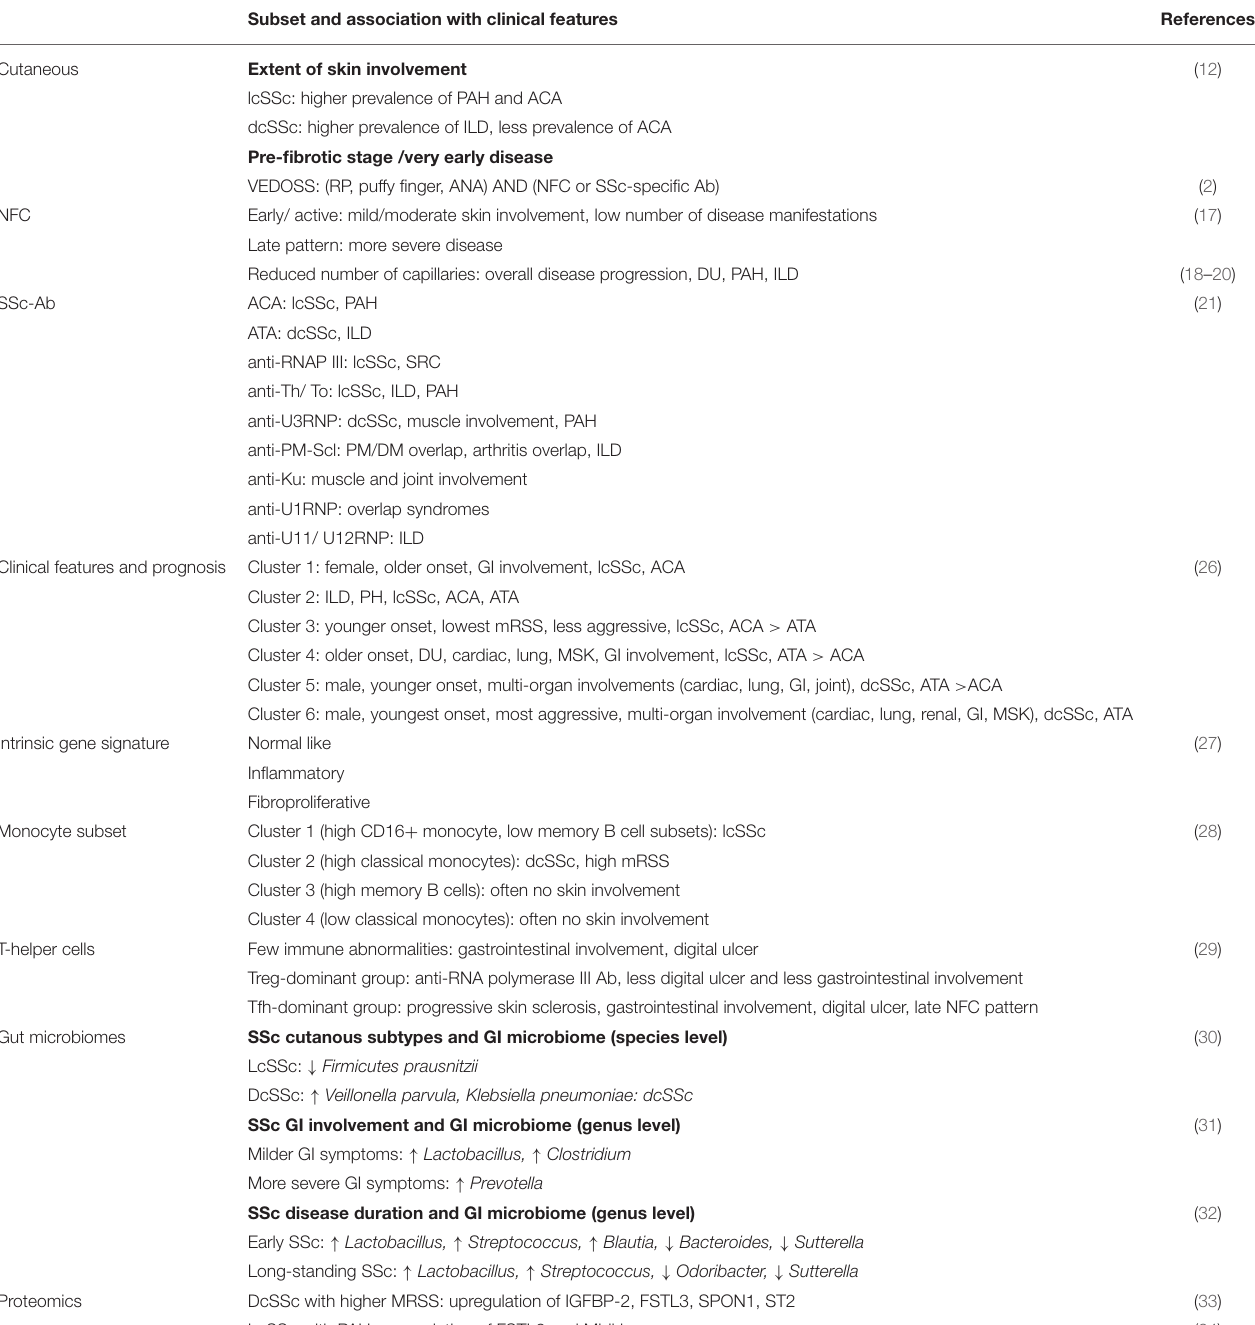
TABLE 1 | Stratification in relation to clinical features. Subset and association with clinical